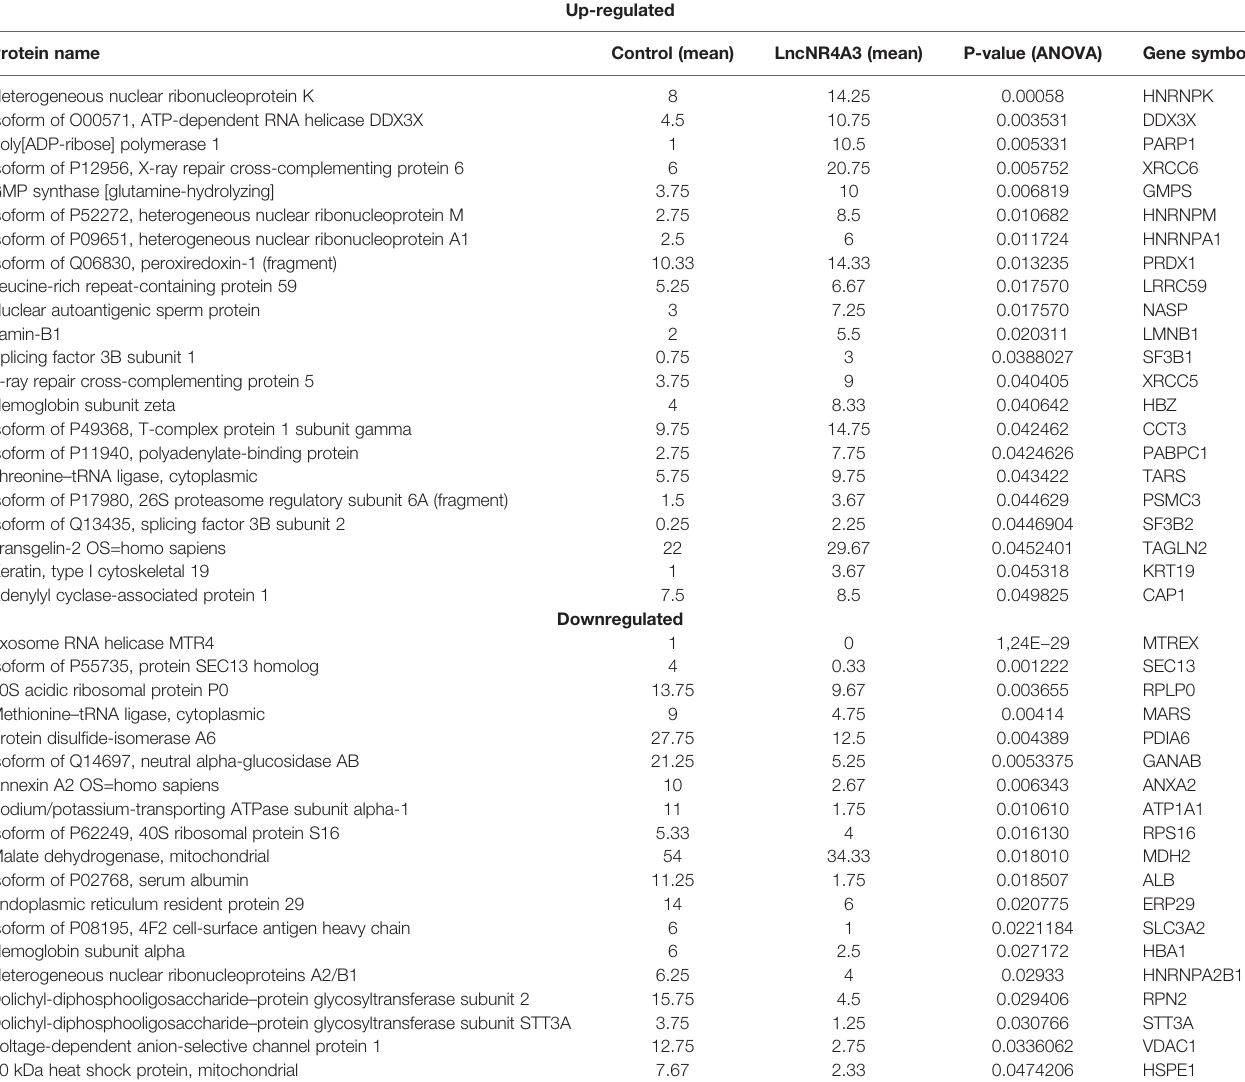
TABLE 2 | MS-proteomics analysis